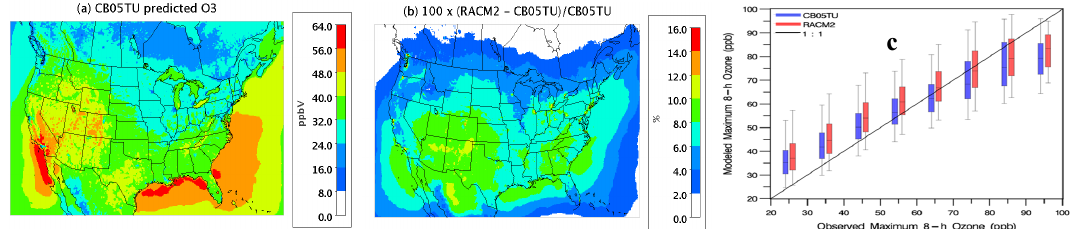
Fig. 5. (a) Predicted mean surface O 3 obtained with CB05TU, (b) percent differences in mean O 3 between RACM2 and CB05TU, (c) a comparison of predicted mean 8h O 3 to observations from the Air Quality